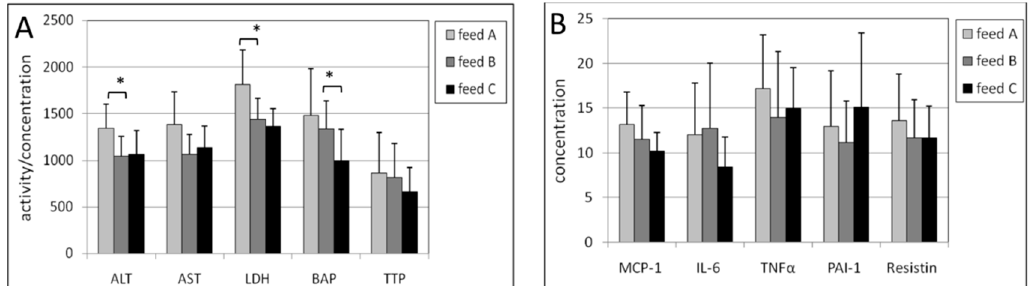
Figure 4. ( A ) Activities of ALT, AST and LDH, and concentrations of BAP and TTP in the post-mitochondrial supernatant of liver tissue of female mice. The levels of AST, LDH, BAP and TTL were multiplied by a factor of 0.5, 0.2, 10 and 10, respectively to fit in the figure; ( B ) Concentrations of MCP-1, IL-6, TNF- α , PAI-1 and resistin in the post-mitochondrial supernatant of liver tissue of female mice. The levels of IL-6, TNF- α and resistin were multiplied by a factor of 4, 3 and 4, respectively to fit in the figure. The levels of feed B were tested statistically relative to those of feed A, and the levels of feed C relative to those of feed B. * p < 0.05.